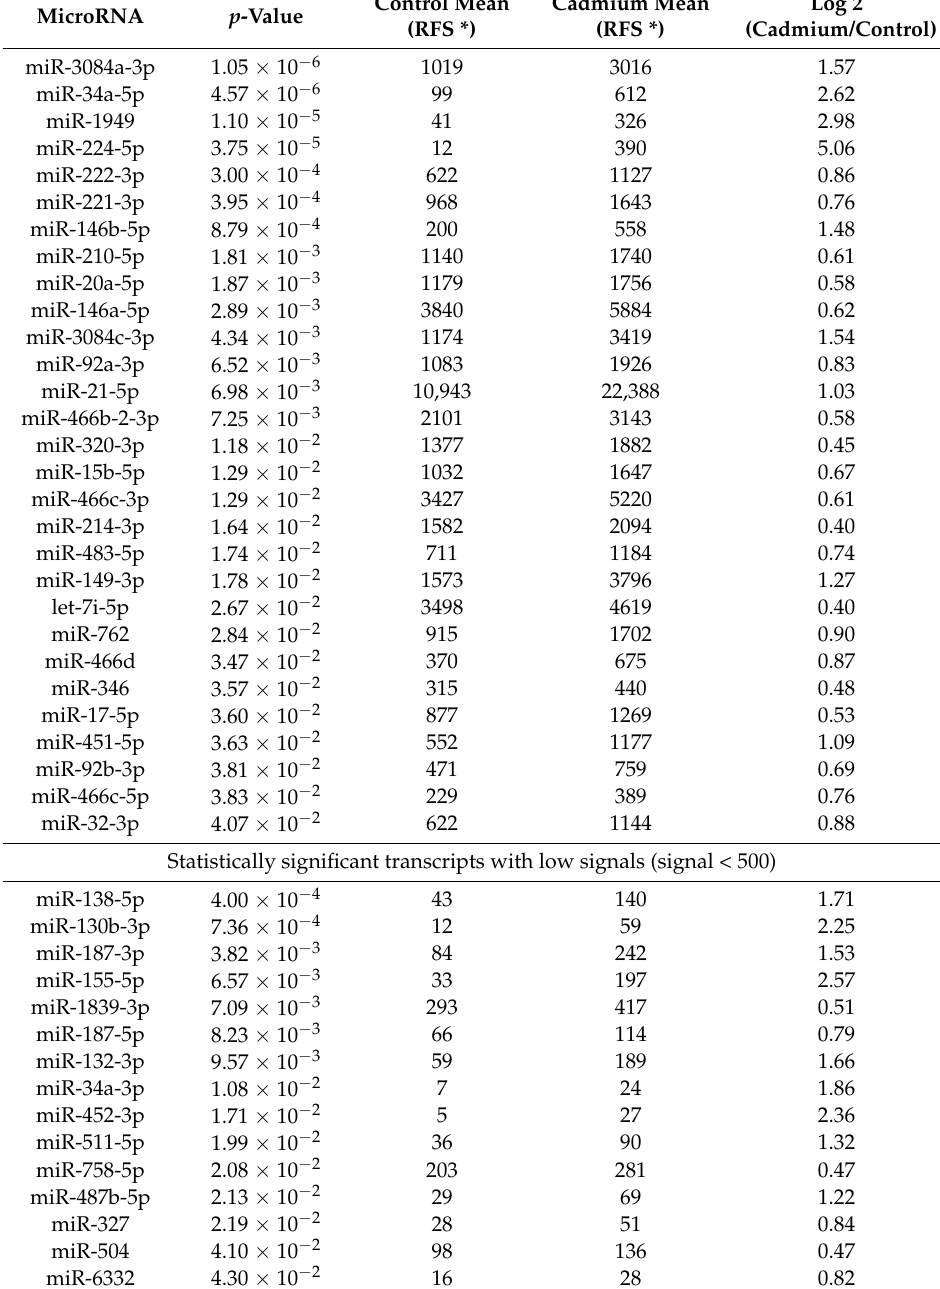
Table 1. MicroRNAs with significantly increased expression in the renal cortex of Cd-treated rats as determined by µ Paraflo™ microRNA microarray